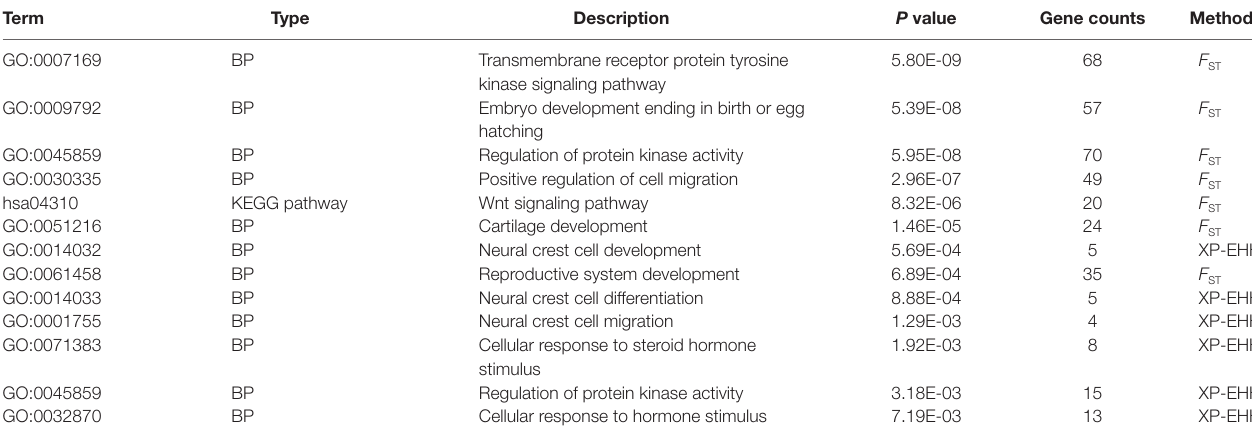
TABLE 4 | Gene enrichment analysis showing the functions of important genes in melanogenesis and